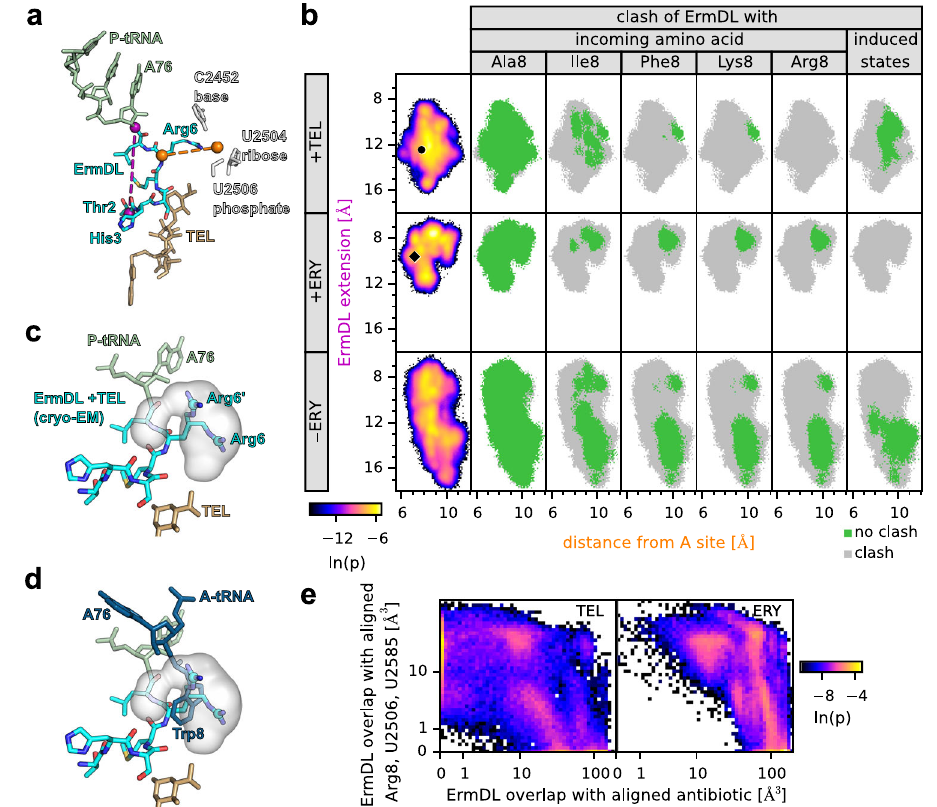
Fig. 6 Dynamics of ErmDL obtained from MD simulations. a Molecular model of the ErmDL nascent chain, P-site tRNA, and telithromycin (TEL) from the ErmDL-TEL-SRC. The ErmDL extension (purple dashed line) is de fi ned as the distance between O3 ′ atom of A76 (P-site tRNA) and C α atom of Thr2. The position of the A site (right orange sphere) is de fi ned as the center of geometry of the base-atoms, ribose-atoms, and phosphate-atoms of C2452, U2504, and U2506, respectively. The ErmDL distance from the A site (orange dashed line) is the distance between the C α atom of Arg6 and the position of the A site. b Distance densities and clashes characterizing ErmDL fl uctuations. The fi rst column displays the logarithm (color coded) of the probability density p along the two distances indicated in a . The distances found in the cryo-EM structures with TEL and ERY (circle and diamond) are also shown. In columns 2 – 6, gray areas indicate distances where all conformations clash with the aligned Ala8, Ile8, Lys8, Arg8, and the induced states of 23S rRNA nucleotides (U2506, U2585), respectively. Green denotes regions with conformations that do not clash. c , d For the C ζ atom of Arg6, the probability density of its positions sampled in the + TEL simulations is shown (gray isosurface at p = exp( − 10)) in comparison with the two Arg6 conformations (C ζ atoms shown as spheres) of the ErmDL-TEL-SRC cryo-EM structure (cyan). Comparison with rotamer conformation of Trp8 ( d ) that clashes with all conformations obtained from the + TEL MD simulations. e For simulations after the removal of ERY, the probability density of the van der Waals-overlap of ErmDL with the aligned antibiotic (TEL, left panel; ERY right panel) as well as with aligned A-site Arg8 and the induced nucleotides is